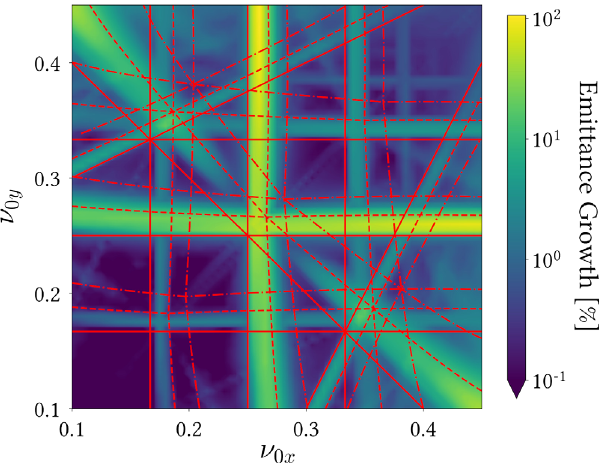
FIG. 6. Tune diagram obtained from 2D W ARP simulations with the initially equipartitioned beam. The beam intensity has been fixed to the value that gives η x ¼ η y ¼ 0 . 9 at the operating point ð ν ; ν Þ ¼ ð 1 = 6 ; 1 = 6 Þ . The initial rms emittances ε 0 x 0 y operating point are determined such that the requirement in Eq. (11) is met. Other numerical conditions and the definitions of the red lines are the same as in Fig. 3. Note that the third-order difference resonances with ð k; l ; n 0 Þ ¼ ð 2 ; − 1 ; 0 Þ and ð 1 ; − 2 ; 0 Þ have been extremely